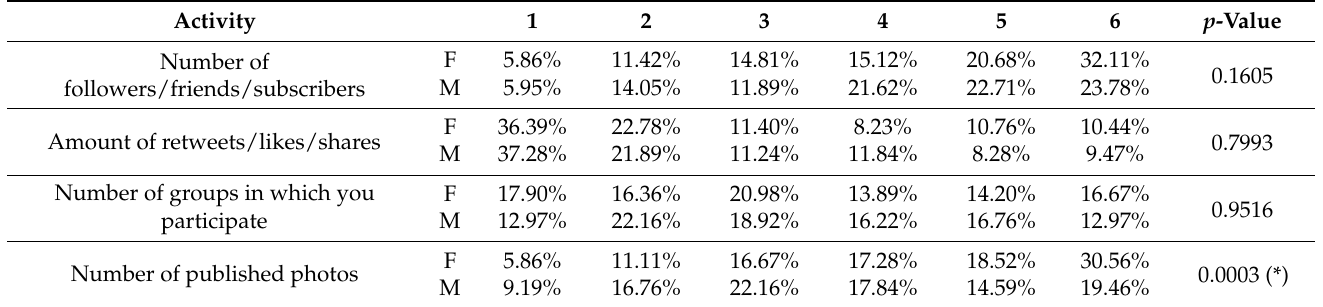
Table 8. Degree of knowledge regarding activities carried out on the Internet.